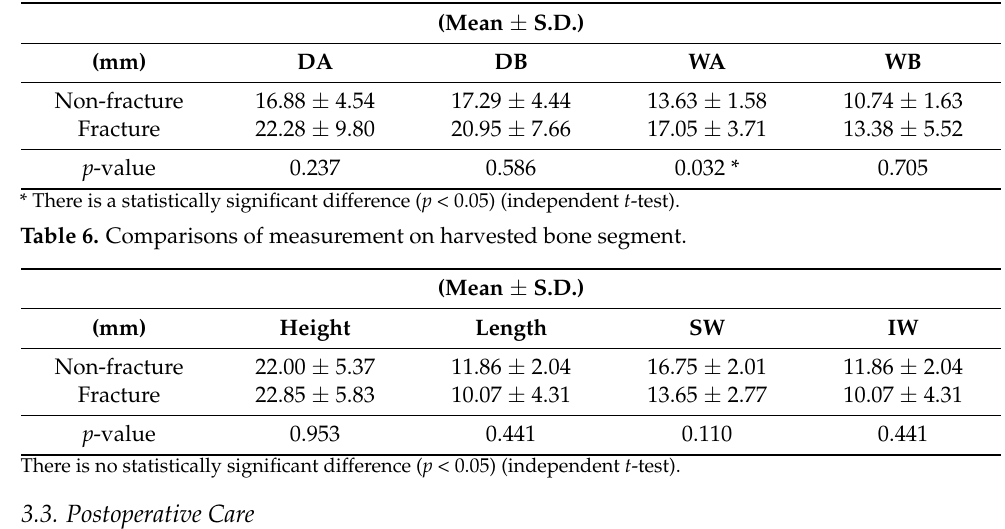
Table 5. Comparisons of non-fracture and fracture groups.